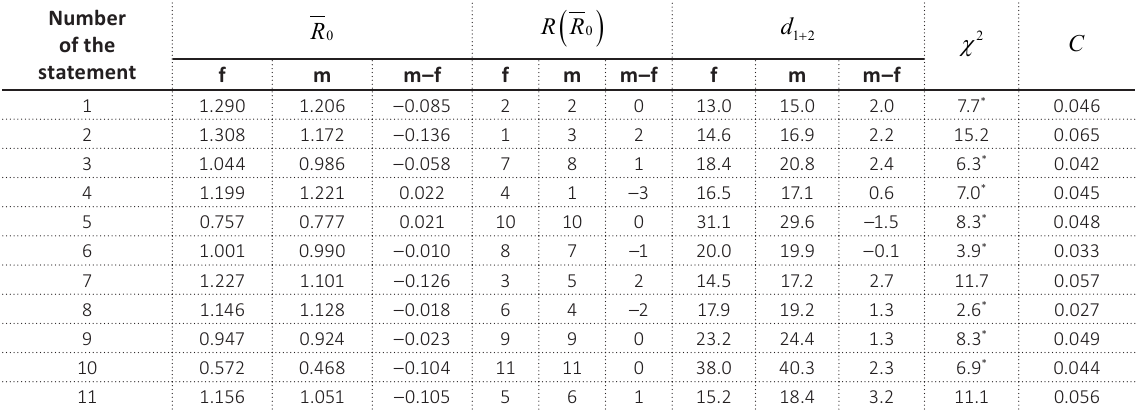
Table 2. Assessment of the threats to starting own